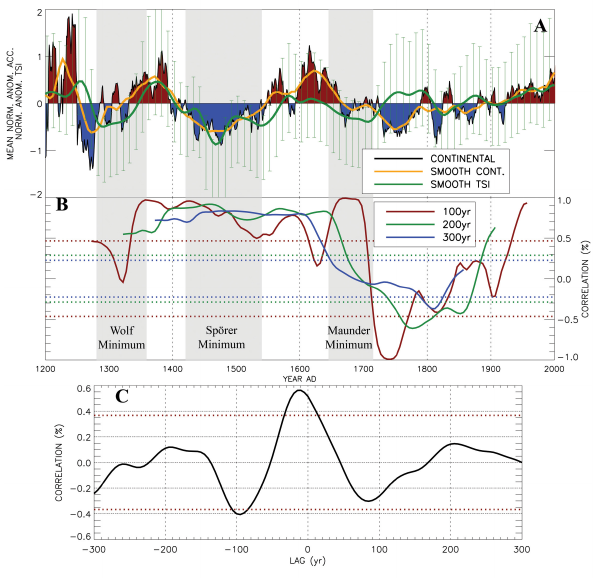
Fig. 5. (A) Mean normalised stacked SMB anomaly time series at the continental scale, calculated as described in the text (black line with positive and negative values filled in with red and blue con- tours, respectively) and the 40-yr central running average smoothing (orange line). The green line represents the normalised TSI anoma- lies, and the corresponding ± 1 σ uncertainties are indicated by the green vertical bars. (B) Running correlations in 100-, 200-, and 300- yr time windows (red, green, and blue solid lines, respectively) be- tween the normalised TSI anomaly and the continental accumula- tion record, smoothed as described in the text. The red, green, and blue dashed lines represent the threshold values corresponding to the 95% statistically significant level based on a two-tailed Student t-test (100-, 200-, and 300-yr time running windows, respectively). The filled grey areas represent the Wolf, Sp¨orer, and Maunder min- imums in solar activity. (C) Correlations at different time lags be- tween the normalised TSI anomaly and the continental accumula- tion record, smoothed as described in the text. The red line rep- resents the threshold value corresponding to the 95% statistically significant level based on a two-tailed Student t-test.